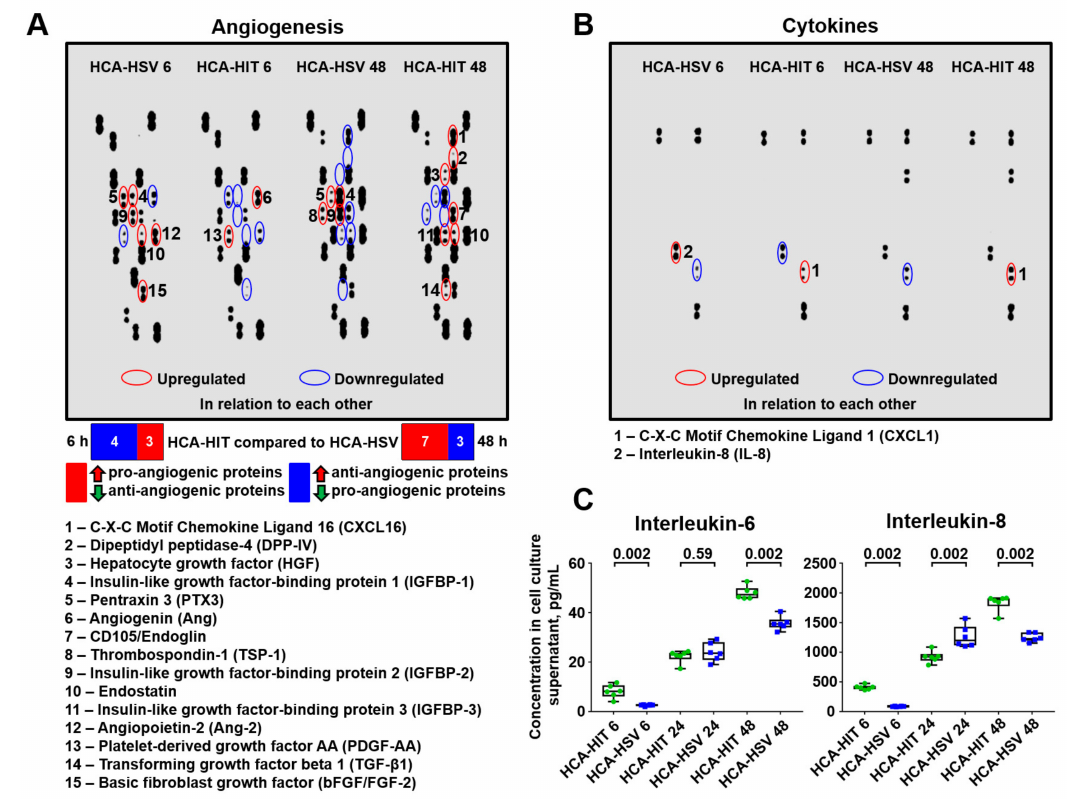
Figure 3. Secretome profiling in the supernatants from HCAEC–HITAEC and HCAEC–HSaVEC co-culture models collected at 6- and 48-h time points. ( A ) Measurement of 55 human angiogenesis-related proteins. ( B ) Measurement of 36 cytokines, chemokines, and acute phase proteins. Those upregulated or downregulated in the HCAEC–HITAEC (HCA-HIT) co-culture model in comparison with the HCAEC–HSaVEC (HCA-HSV) model are circled in red and blue, respectively. ( C ) High-sensitivity enzyme-linked immunosorbent assay measurements of interleukin-6 and interleukin-8. For this experiment, we also included a 24-h time point. Each dot represents one aliquot from the co-culture model. Whiskers indicate range, boxes’ bounds indicate 25th–75th percentiles, center lines indicate median. P values provided above boxes, Mann–Whitney